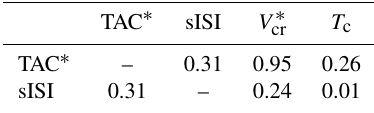
Table 3. Table with the squared correlation coefficients between data and calculated parameters TAC ∗ , sISI, V ∗ cr and T c